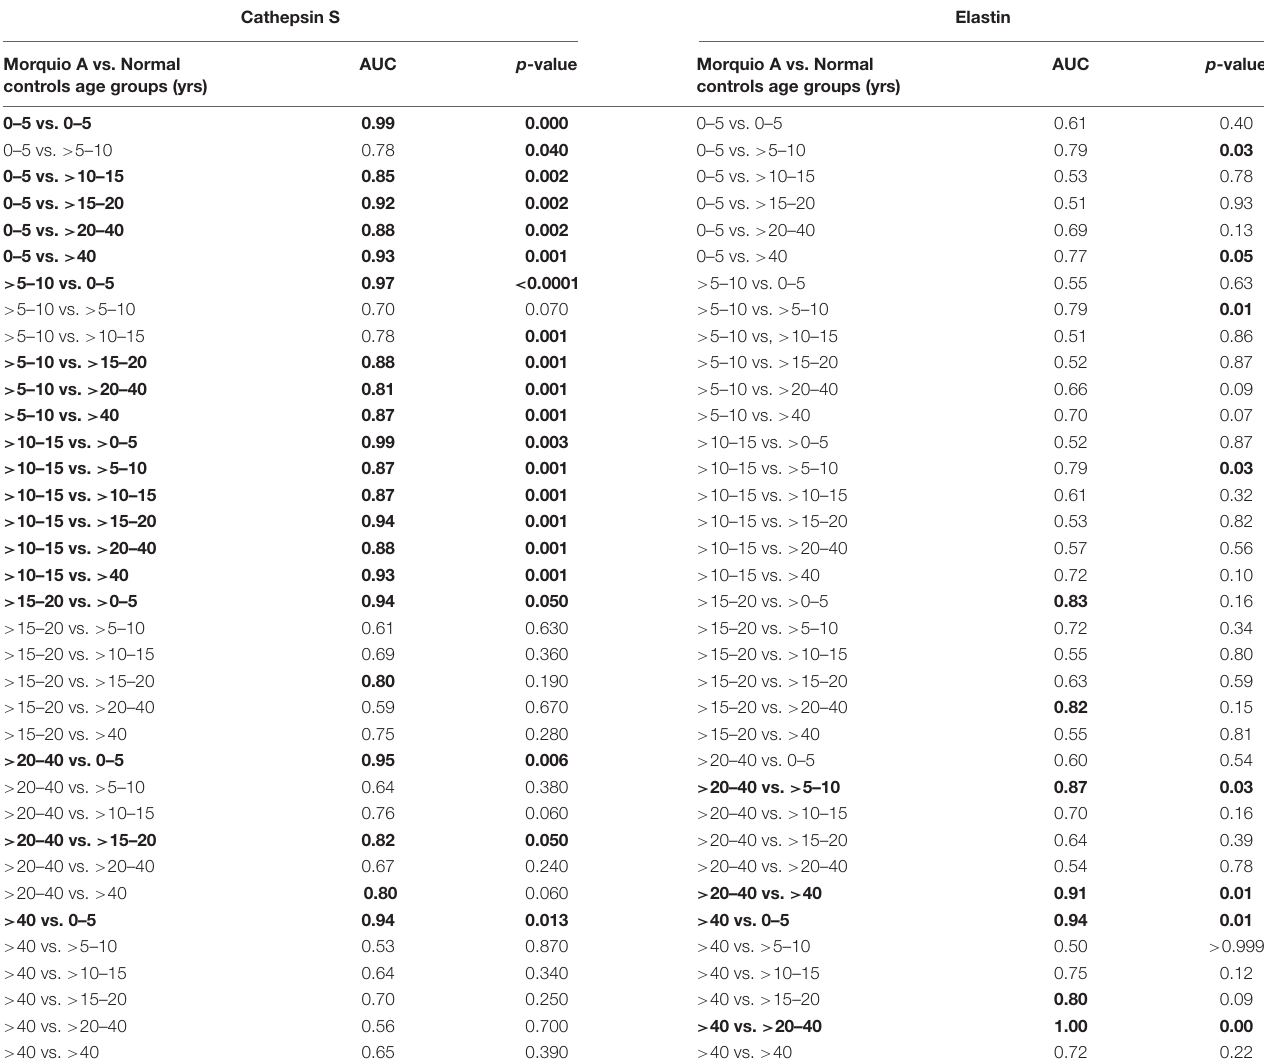
TABLE 4 | Receiver operating characteristic area under the curves for cathepsin S and elastin. Cathepsin S Elastin Morquio A vs. Normal controls age groups